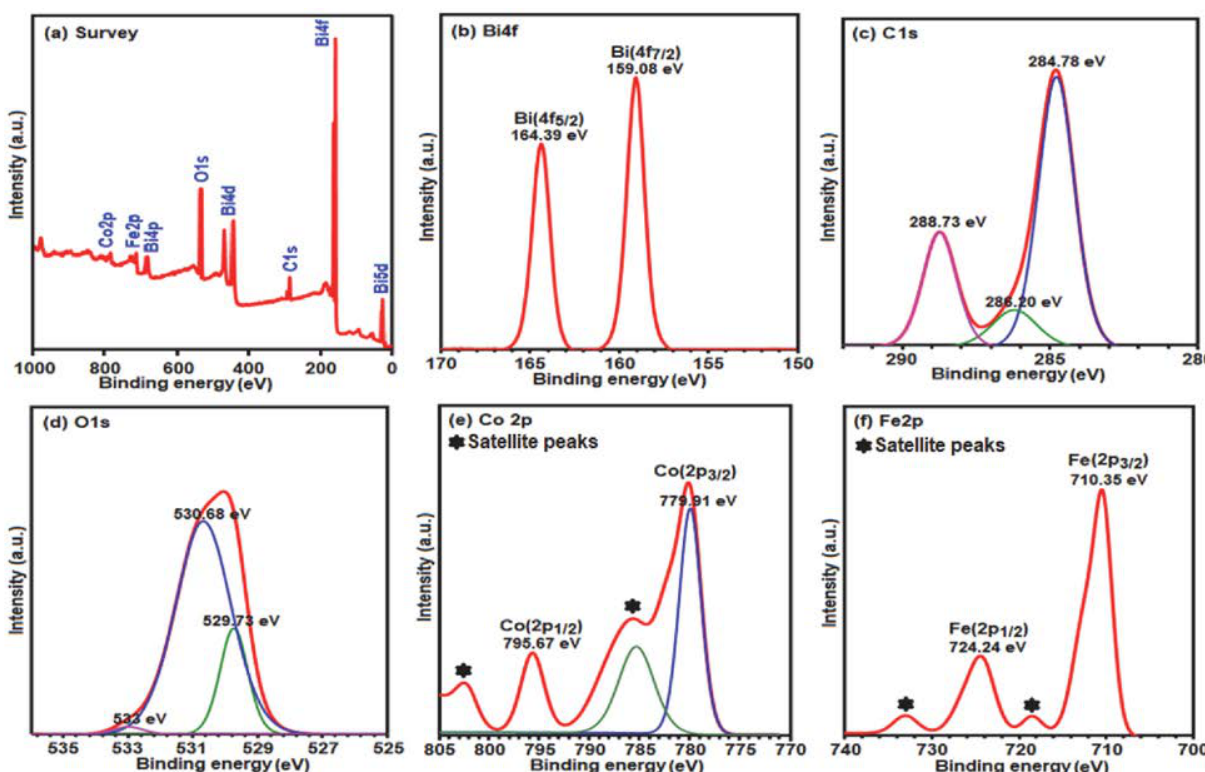
Figure 8. (a) XPS survey spectrum of the Bi 2 O 2 CO 3 /CoFe 2 O 4 30% nanocomposite. High-resolution XPS spectra of (b) Bi 4f, (c) C 1s, (d) O 1s, (e) Co 2p and (f) Fe